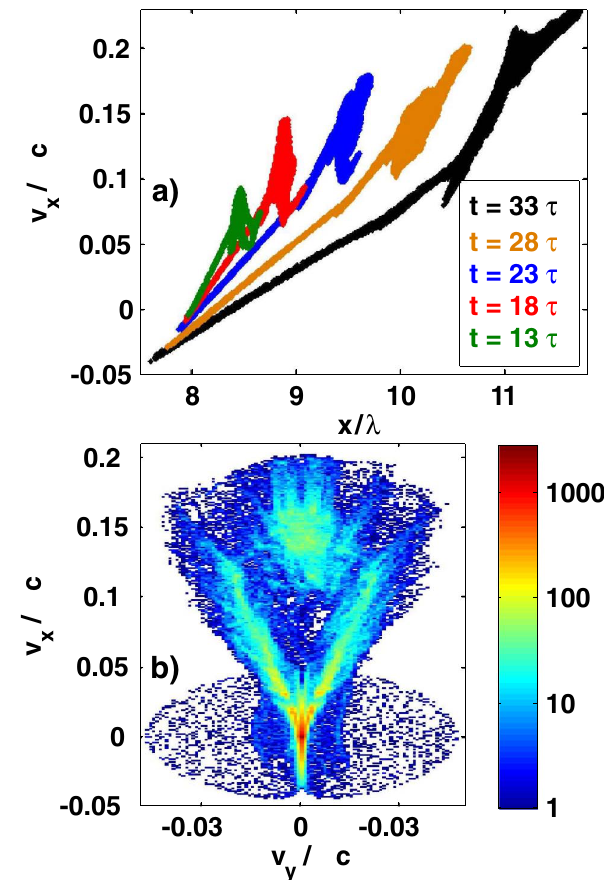
FIG. 10. (Color) Temporal evolution of the ion phase space [panel (a)] and the ion velocity distribution in the interaction time 28 (cid:2) [panel (b)] in the 2D3V PIC simulation. The parameters are the same as in Fig. 8. The ion phase space contains only ions located in the 2 (cid:1) wide central part of the simulation box. All ions are included in the velocity distribution in panel (b), where the color scale is logarithmic and the number of ions is in arbitrary